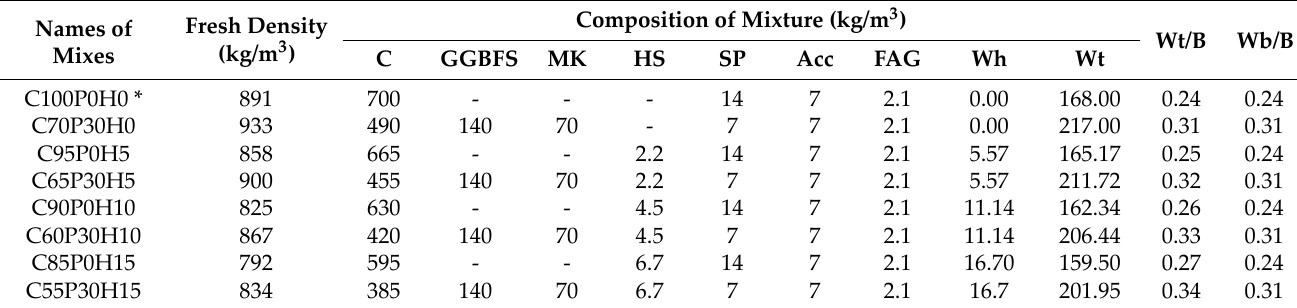
Table 3. Foamed concretes composition and